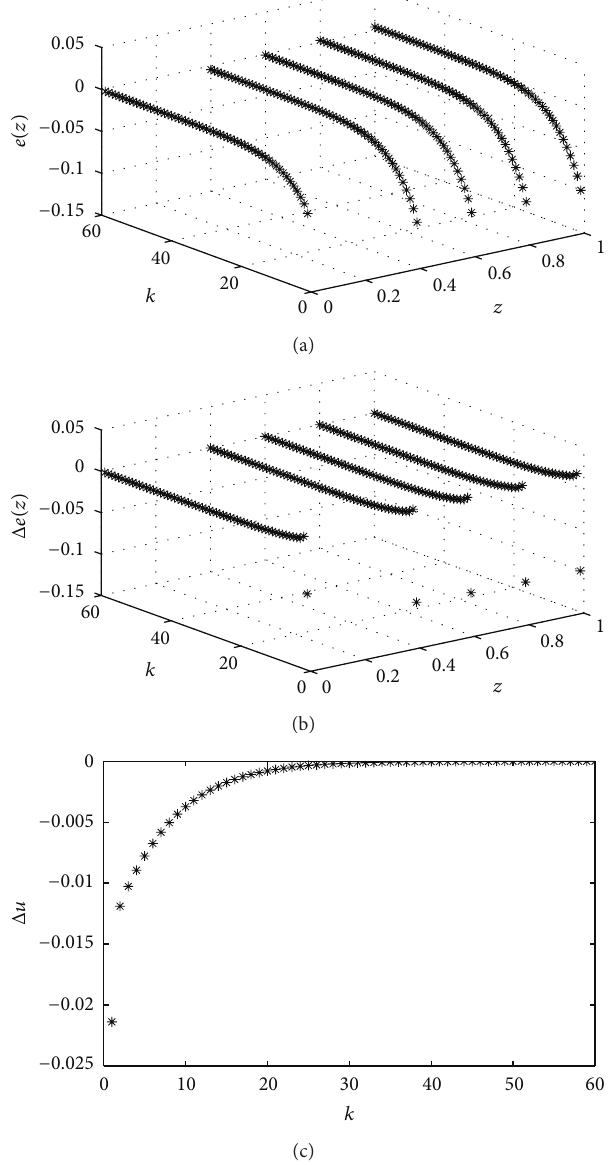
Figure 6: Spatial-temporal data set: (a) spatial error 𝑒(𝑧) ; (b) spatial error in change Δ𝑒(𝑧) ; (c) incremental output Δ𝑢 ( 𝑧 : spatial dimension; 𝑘 : serial number of input-output